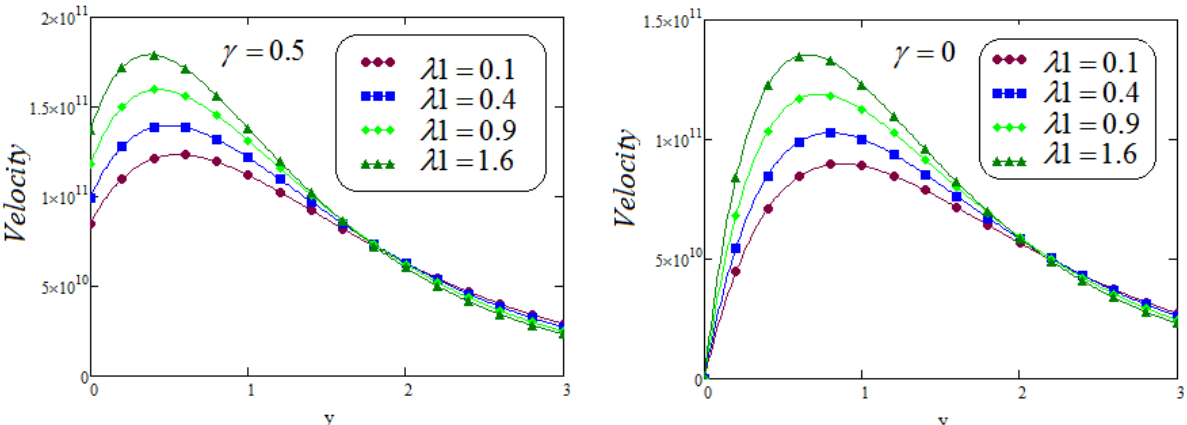
Figure 6. Velocity field under slip conditions as well as the velocity field under no-slip conditions for different λ 1 values when f ( t ) = e at , a = 0.25, t = 1.5, Gr = 3.5, Pr = 0.71, λ 2 = 0.2, M = 2.